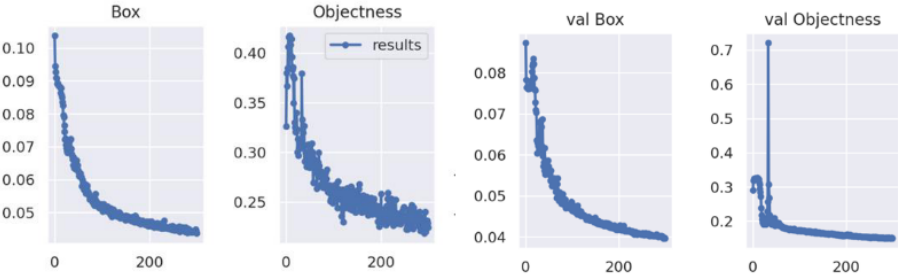
Figure 5. Convergence of the loss functions of training and validation sets (Box and Objectness are the frame loss and hens’ loss of training set respectively; val box and val objectness are the frame loss and hens’ loss of validation set, respectively).